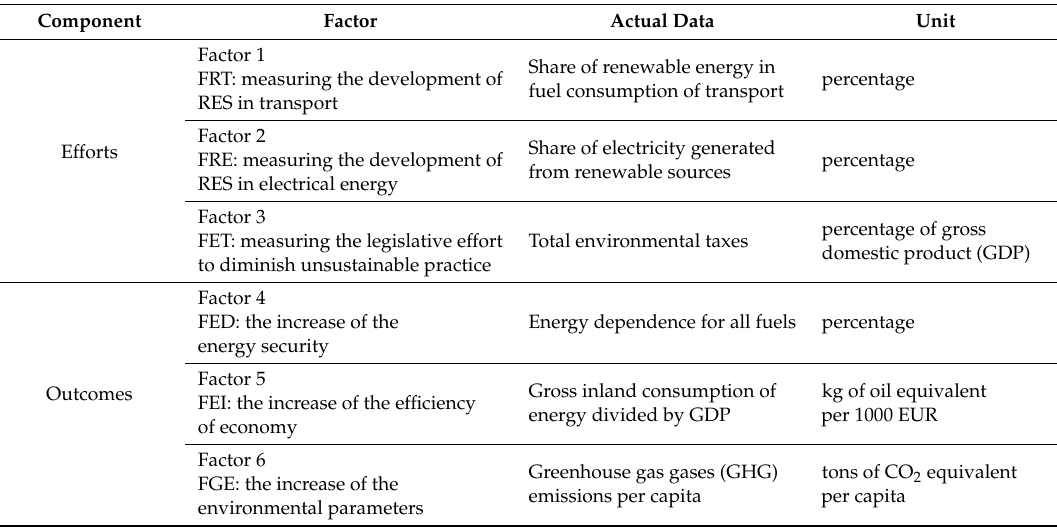
Table 3. Components and factors of energy model